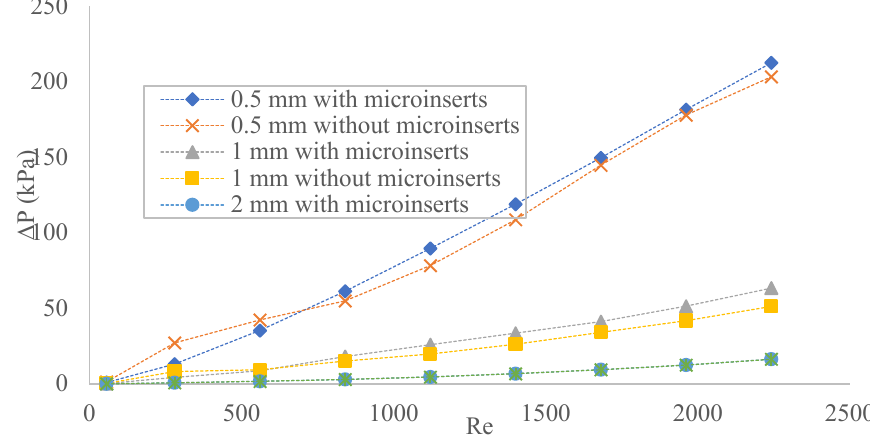
Figure 6. The pressure drop as a function of Reynolds number.